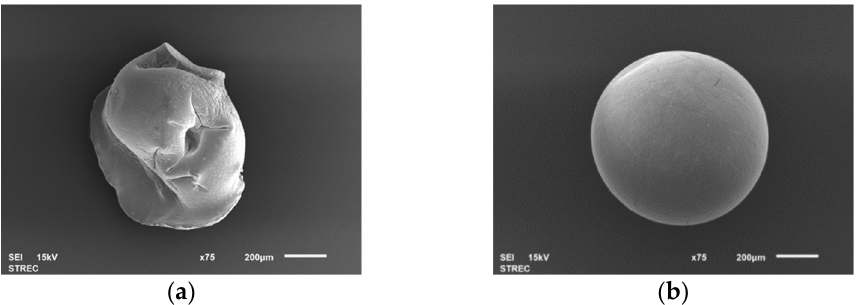
Figure 1. Morphology of ( a ) the control and ( b ) Mesona chinensis bead (MCB) under a scanning electron microscope (SEM).